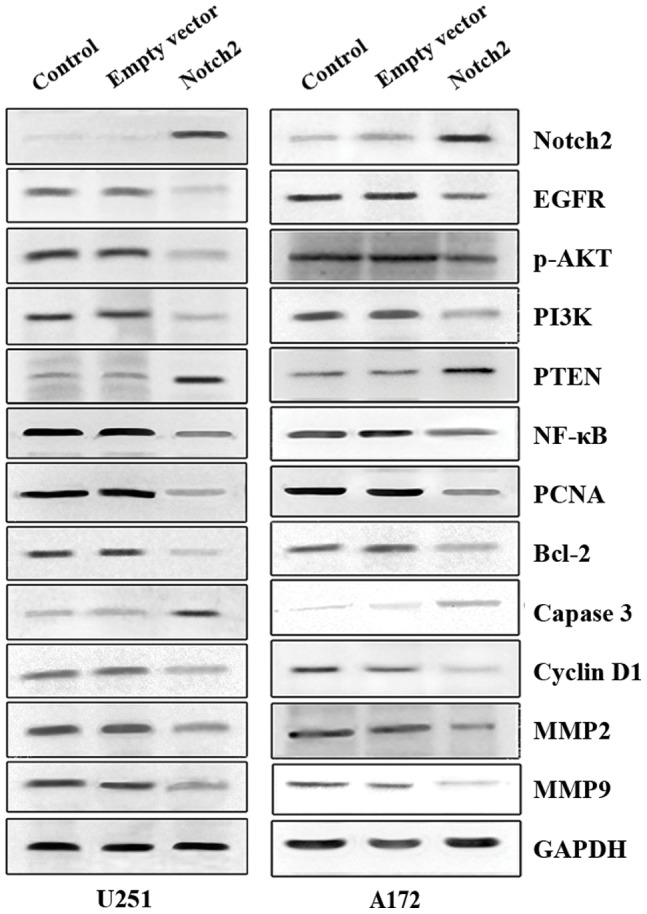
Expression of EGFR/PI3K/AKT pathway relative genes in U251/A172 cells transfected with Notch2 construct by Western blot.Western blot analysis of EGFR, phosphorylated AKT (p-AKT), PI3K, NF-κB, PCNA, Bcl-2, Caspase-3, CyclinD1, MMP2 and MMP9 expression in U251/A172 cells transfected with Notch2 construct.